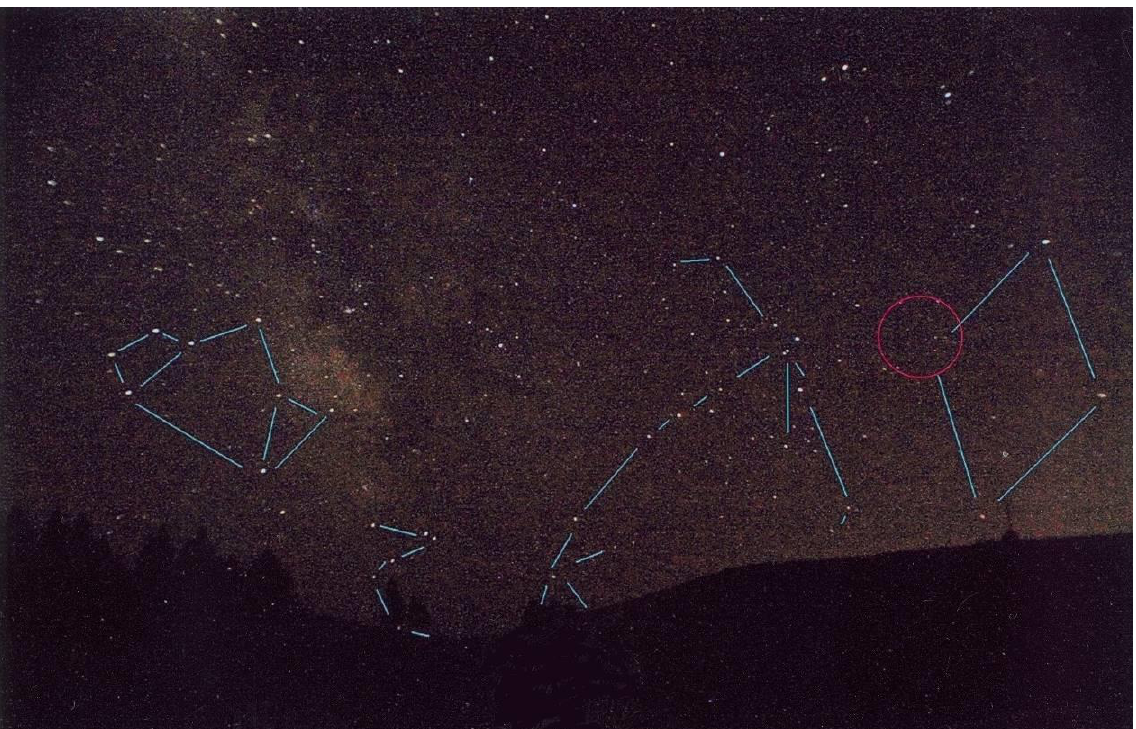
Figure 34. Photo of the southern night sky from the dark skies of the Pine Ridge reservation in South Dakota. The ‘helper lines’ show the constellations of Sagittarius, sometimes known as the ‘teapot’ (at left), with the Milky Way the ‘puff of steam’ coming from the spout and the stars in Scorpius configured as the Star Being (at center). The diamond shape at right is Libra. The red circle shows where the Autumnal equinox rose in the background of stars ca. 4000 BCE (see Figures 29 and